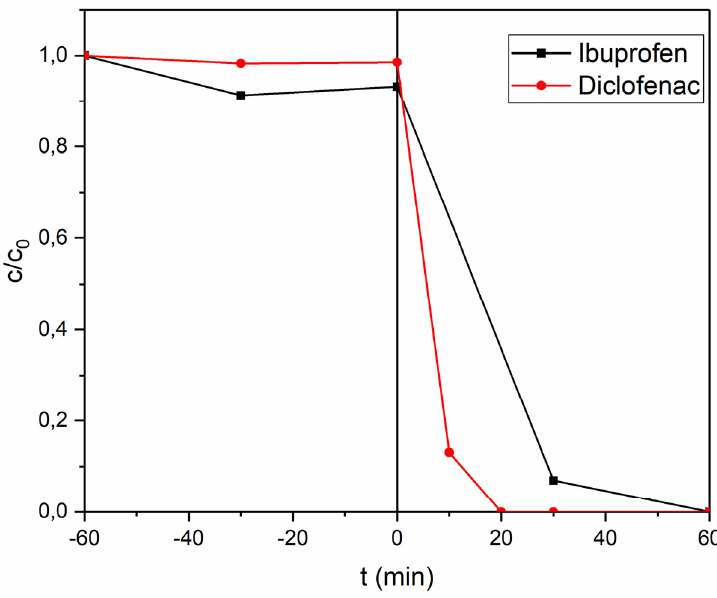
Figure 9. Adsorption and photocatalytic degradation of ibuprofen and diclofenac using sample A